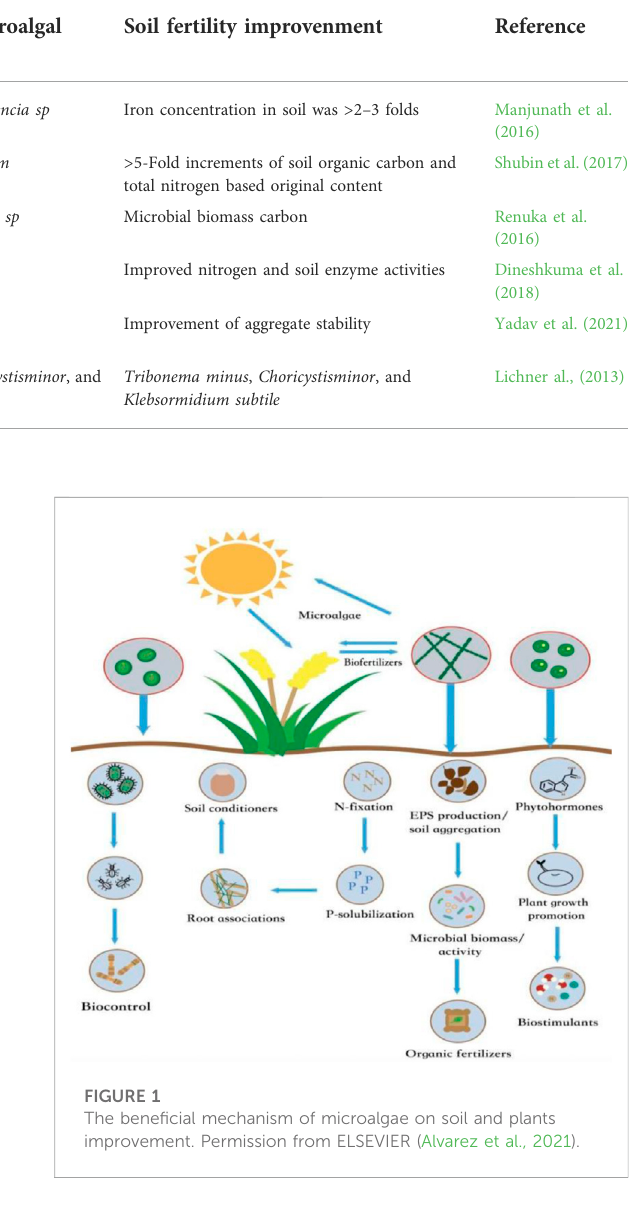
TABLE1Improvementofsoilhealthandfertilitywithdifferentmicroalgae.AdaptedwiththepermissionfromTaylor&FrancisOnline(Abinandaetal., 2019).